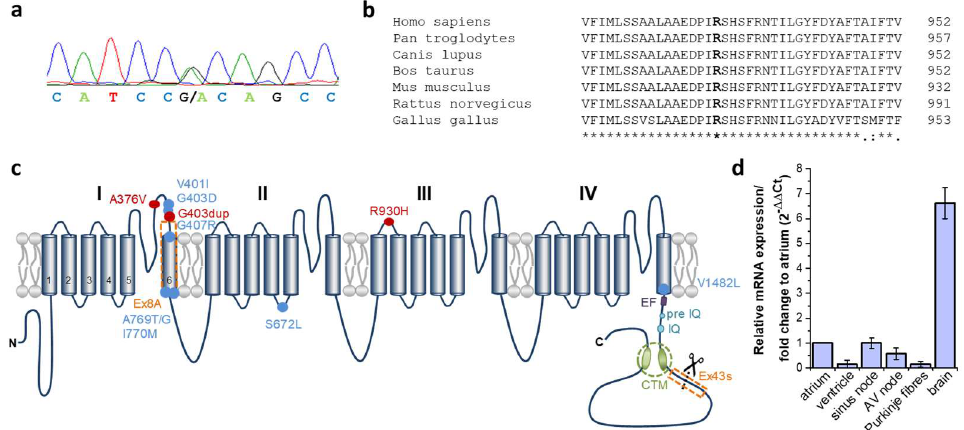
Figure 2. Conservation and localization of the heterozygous CACNA1D variant R390H. ( a ) Electropherogram of the proband (III:1) with the heterozygous CACNA1D nucleotide variant c.2789G>A (NM_000720.3). The peaks represent each base in the gDNA sequence (red, thymine; green, adenine; black, guanine and blue, cytosine). ( b ) Multiple sequence alignment of the human CACNA1D protein region encompassing arginine 930 with orthologous protein sequences. Identical amino acids are indicated by an asterisk and highly conserved amino acids by a colon in the lower lane. The mutated amino acid residue is indicated in bold. ( c ) The predicted topology of the Cav1.3 channel and structure of the human transcript variants used in functional studies of Cav1.3. Cav1.3 α 1 -subunit comprised of four structurally homologous domains (I, II, III, IV), each containing six transmembrane spanning domains (S1–S6) together with a pore region between transmembrane helices S5 and S6. Both human Cav1.3 constructs used in expression studies (Cav1.3 L and Cav1.3 S ) contain the alternatively spliced exon 8A in domain I (Supplementary File: Figure S1). Alternative splicing in exon 43 located in the C-terminus results in a premature stop codon lacking the distal domain of the C-terminal modulator (CTM) (referred to as Cav1.3 S , Supplementary File: Figure S1) and is highly expressed in the brain, but not in the heart [20]. Mutations related to cardiac conduction disturbances are indicated by a red dot. R930H is located extracellularly in the S1–S2 linker of repeat III. Mutations related to neurologic disorders as epileptic seizures, autism or developmental delay are indicated by a blue dot and mutations related to primary hyperaldosteronism by a black dot. The EF, pre-IQ and IQ motifs function as interaction sites for calmodulin. ( d ) Expression of human CACNA1D exon 22 (harboring the variant at residue 930) in different human heart compartments and the brain. A real-time PCR and 2 − ∆∆ Ct -method was used to describe the relative CACNA1D mRNA expression in different heart tissue compartments and total brain normalized to atrial CACNA1D